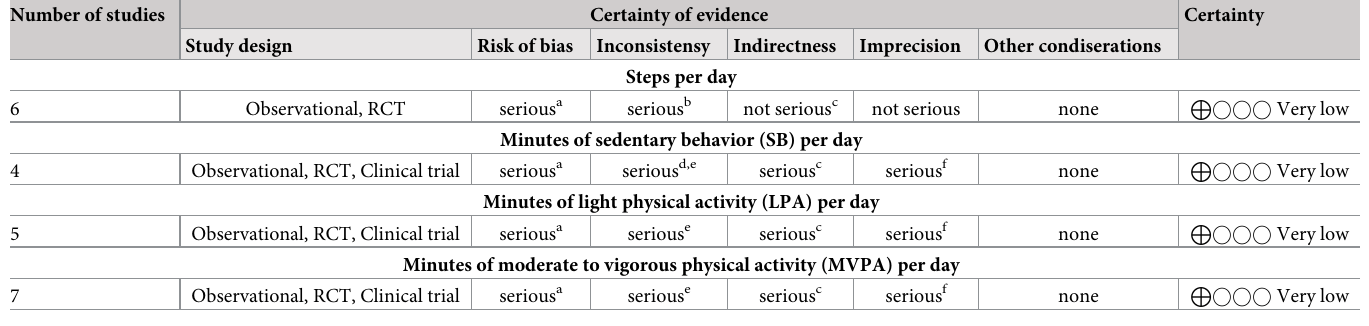
Table 4. Certainty of evidence using the GRADE